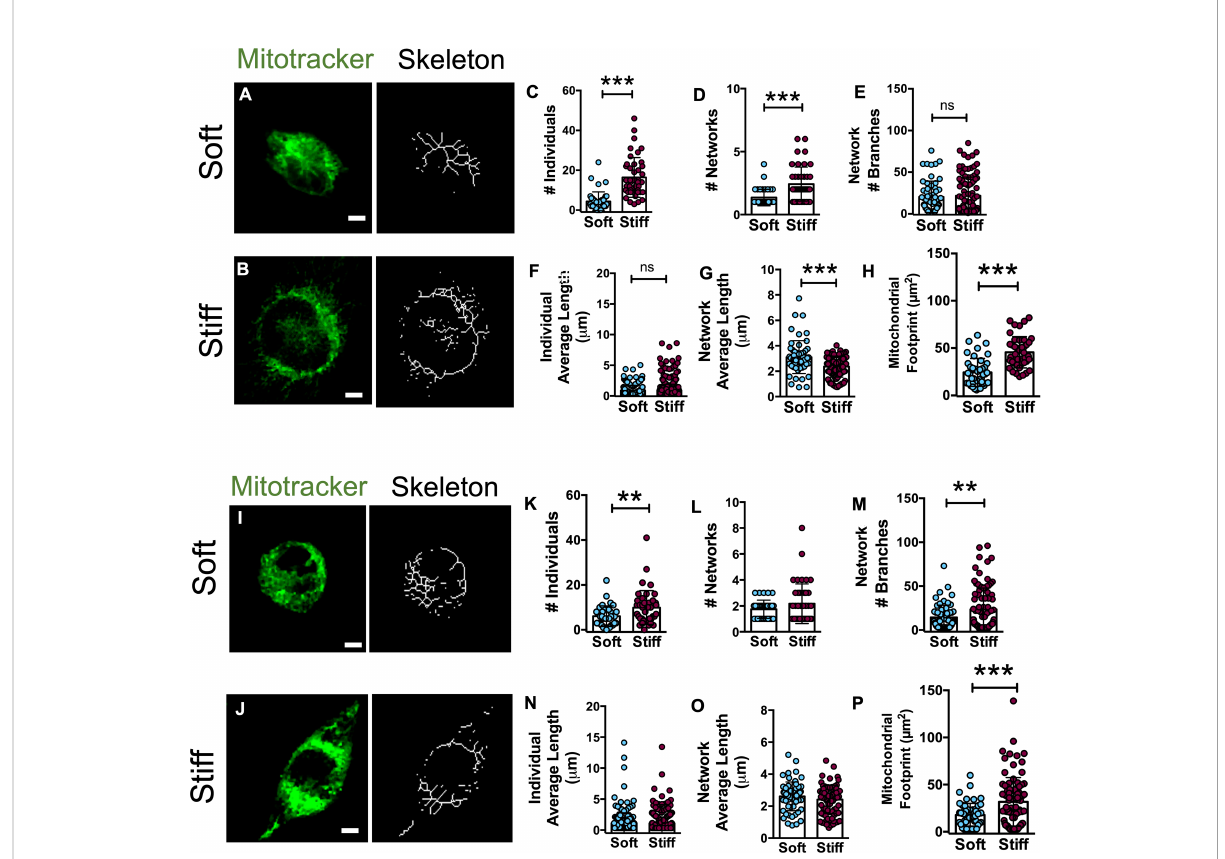
FIGURE 6 Mitochondria organization in U251-MG and GL15 cells is altered by substrate stiffness. Representative confocal images of U251-MG cells seeded on (A) Soft and (B) Stiff substrates and their relative skeletons. Scale bar 5 µm. Quanti fi cation of mitochondrial morphology showing the (C) number of individuals, (D) number of networks, (E) mean network size per branches, (F) mean length of branches/rod, (G) mean network size, and (H) mitochondrial footprint of U251-MG cells on Soft (n = 42 cells/8 fi elds) and Stiff (n = 43 cells/7 fi elds) and substrates. Representative confocal and skeleton images of GL15 cells seeded on (I) soft and (J) stiff substrates. Scale bar 5 µm. Quanti fi cation of mitochondrial morphology showing (K) the number of individuals, (L) number of networks, (M) mean network size per branches, (N) mean length of branches/ rod, (O) mean network size, and (P) mitochondrial footprint of GL15 cells on Soft (n = 35 cells/6 fi elds) and Stiff (n = 42 cells/10 fi elds) substrates. The data are presented as mean ± S.D.; n = 3 independent experiments for each condition. Student ’ s t-test **p<0.01,